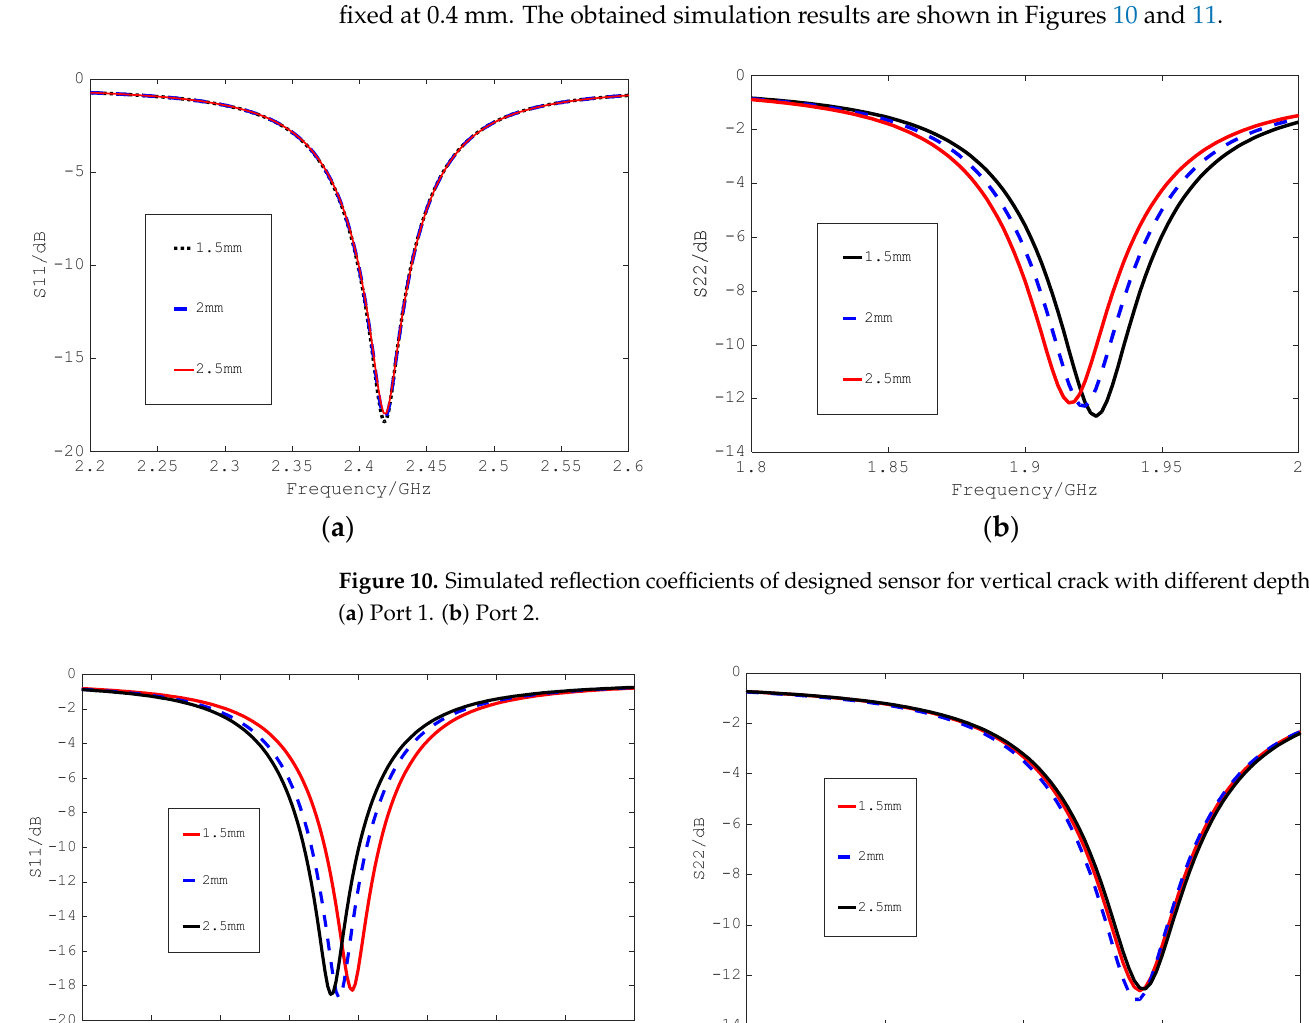
Figure 11. Simulated reflection coefficients of designed sensor for horizontal crack with different depths. ( a ) Port 1. ( b ) Port 2.